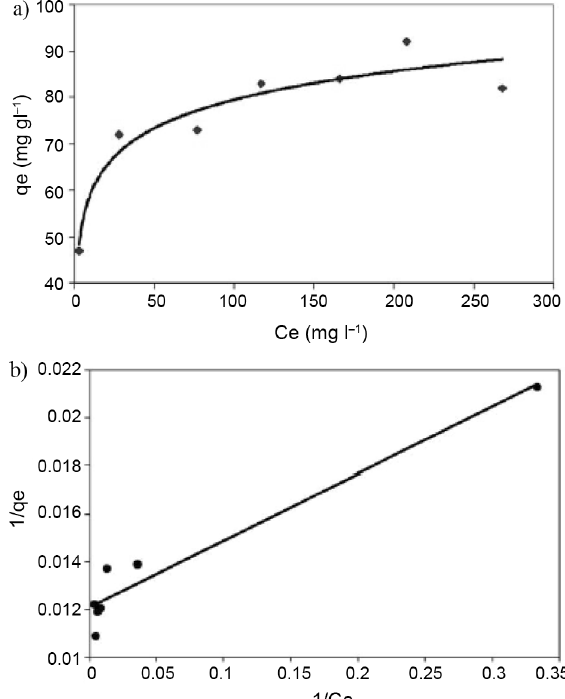
Fig. 4. A plot of q e vs. C e , (a); Langmuir isotherm plot of 1/ q e vs. 1/ C e (b) for biosorption of nickel ions onto pre-treated FGWS. D p = 62.2